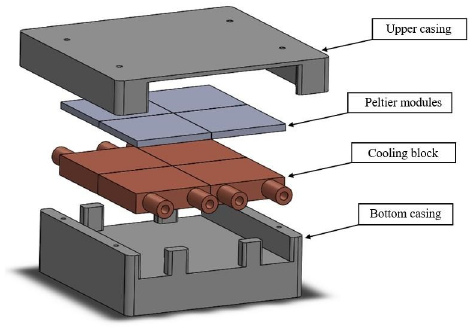
Figure 7. Cooling assembly of bioprinting platform.